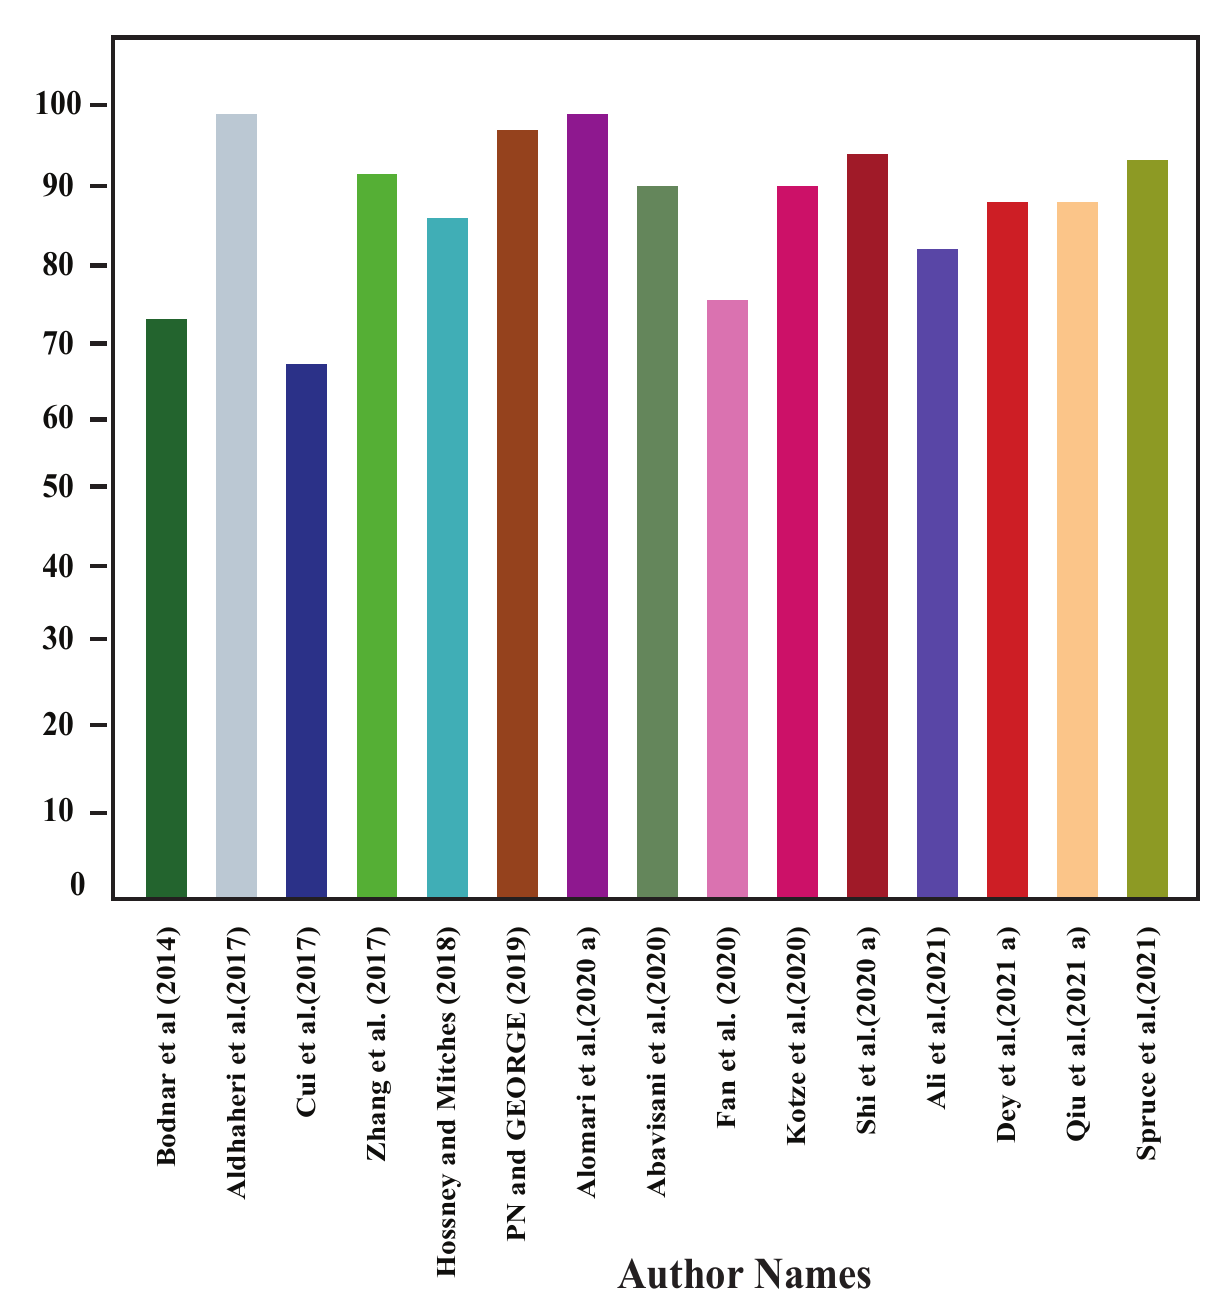
Figure 7. Accuracy-based performance comparisons of the articles. The height of each bar presents an article’s accuracy, which is given in the Y-axis, and the X-axis shows the author’s name. Refs. [3,4,8,19,20,32,37,48,50,58,60,61,68–70] have used accuracy for their performance analysis, and their values are presented using the bars in this